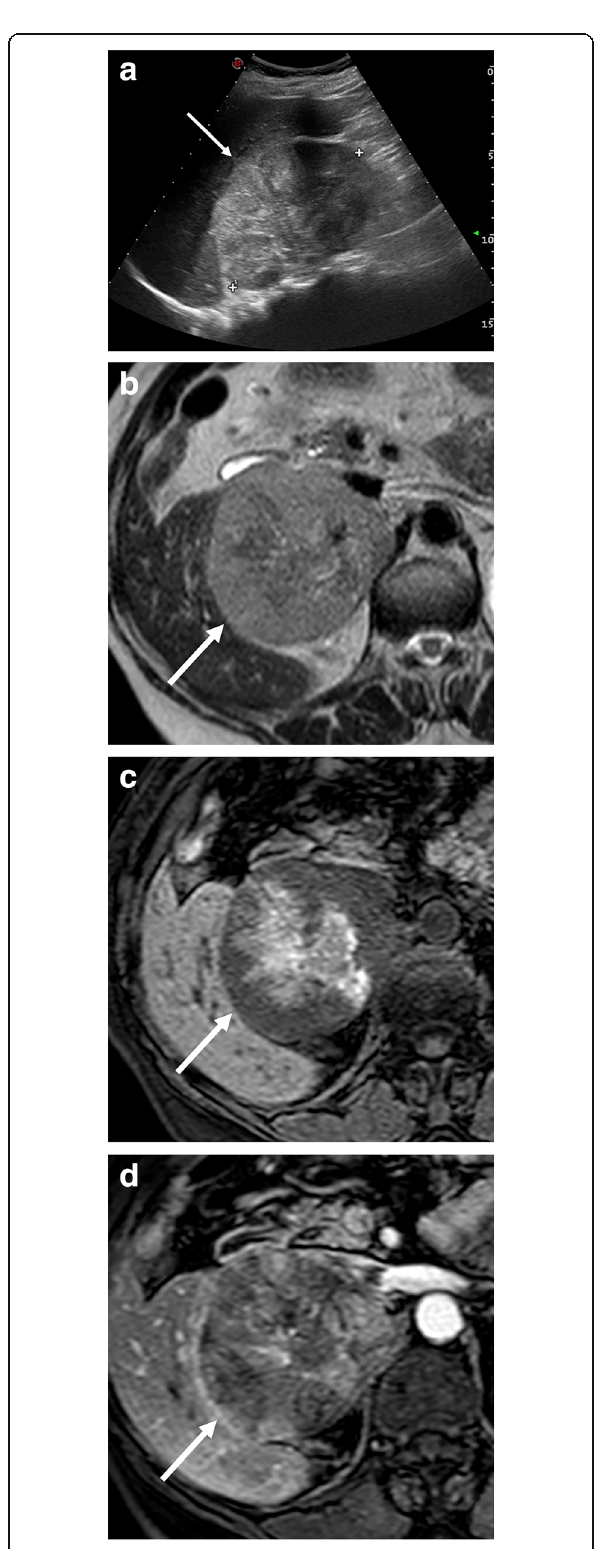
Fig. 8 Right cortical carcinoma in a 70-year-old woman admitted to the emergency department for atraumatic abdominal pain. US ( a ) shows a large heterogeneous right adrenal mass (arrow). Axial T2- weighted spin echo ( b ), three-dimensional fat-suppressed T1- weighted gradient recalled echo images before contrast injection ( c ), in arterial phase ( d ) images confirm the presence of a large right adrenal mass with necrotic and hemorrhagic components which present as areas of high signal on unenhanced T1-weighted ( c ) images and non-enhancing areas after contrast injection ( d